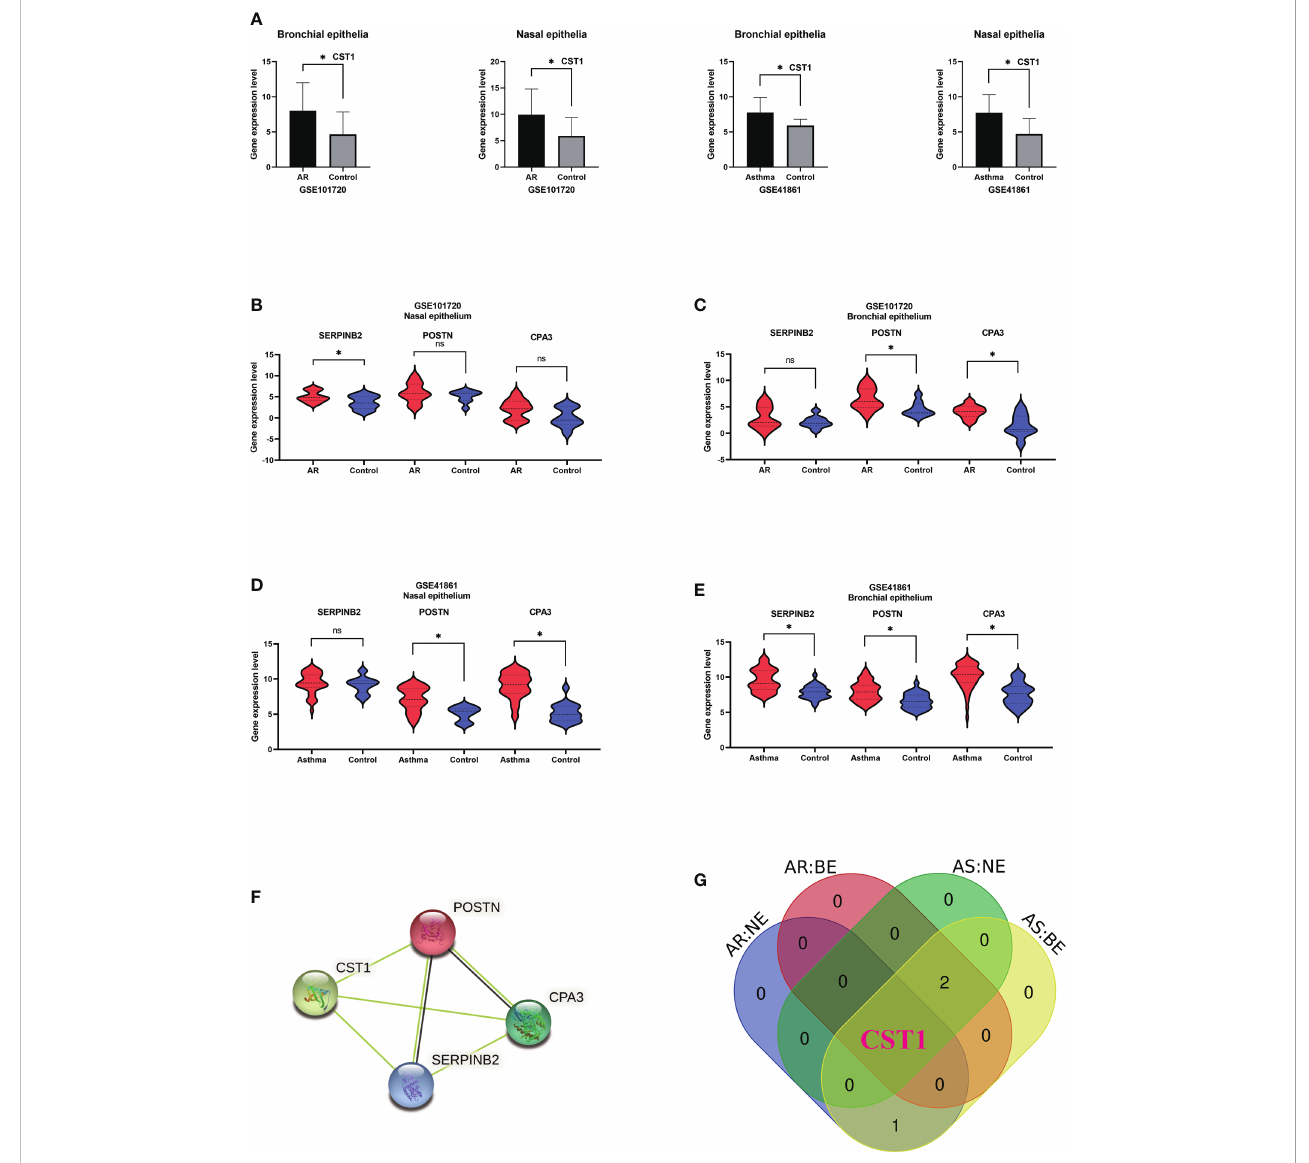
FIGURE 3 Validation of key genes and identi fi cation of upper and lower airway biomarkers. (A) Expression levels of CST1 in nasal and bronchial epithelium of allergic rhinitis and asthma patients in GSE101720 and GSE41861. (B) Expression levels of three key genes in the nasal epithelium of patients with allergic rhinitis in GSE101720. (C) Expression levels of three key genes in the bronchial epithelium of allergic rhinitis patients in GSE101720. (D) Expression levels of three key genes in the nasal epithelium of asthma patients in GSE41861. (E) Expression levels of three key genes in the bronchial epithelium of asthma patients in GSE41861. (F) Interactions between proteins encoded by four key genes. (G) Venn Diagram shows that CST1 is the only key gene whose expression level is up-regulated in nasal epithelium and bronchial epithelium of both AR and asthma patients. AR, Allergic Rhinitis; AS, Asthma; NE, Nasal Epithelium; BE, Bronchial Epithelium; ns, no signi fi cance; *P <